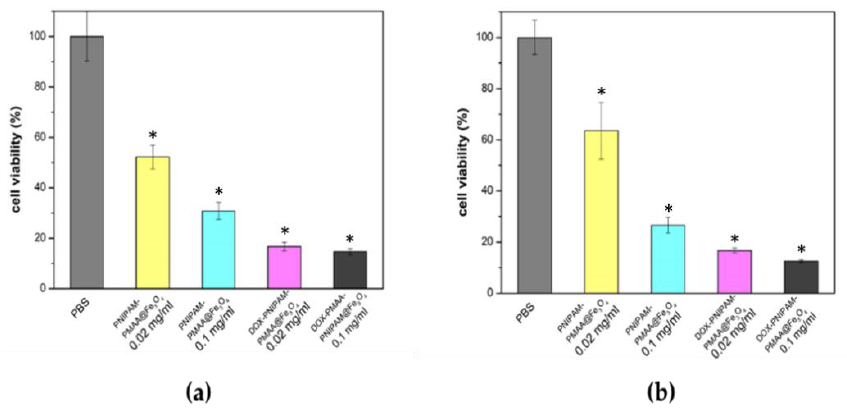
Figure 7. Cell viability analysis. ( a ) Cell viability analysis of the MDA-MB-231 cell line treatment for 48 h. ( b ) Cell viability analysis of the MDA-MB-231 cell line treatment for 72 h. * t -test: P -values